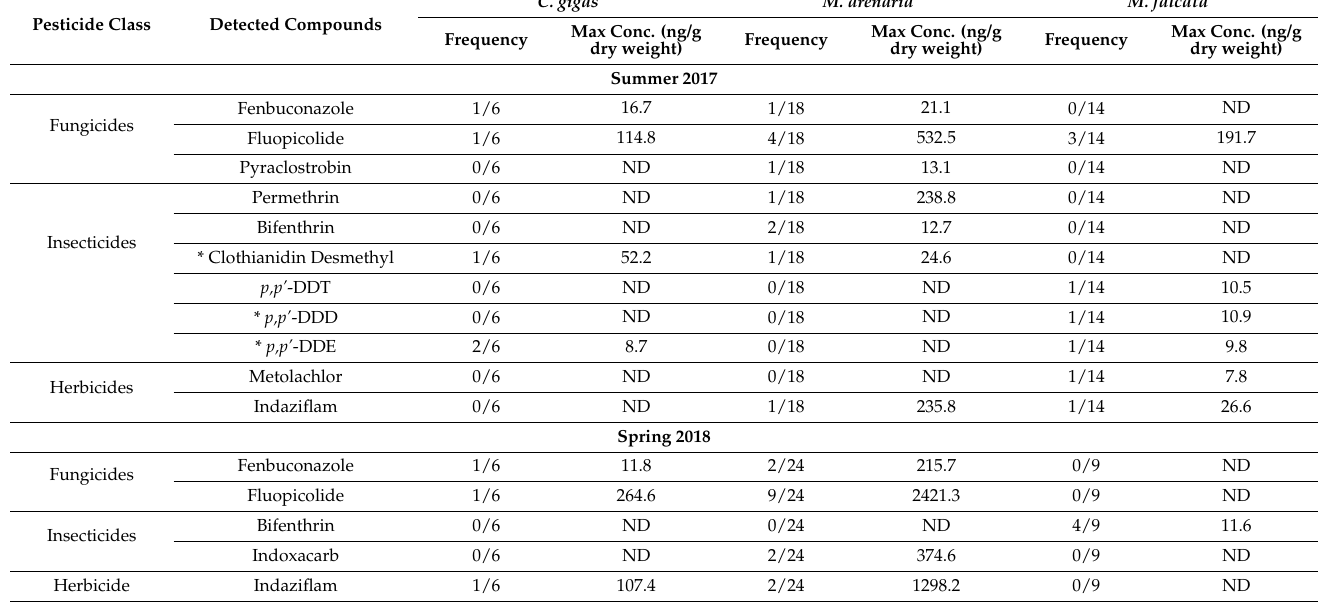
Table 3. Seasonal variability in the class of pesticides, detected compounds, frequency of detection, and maximum concentrations (ng/g dry weight) observed in C. gigas, M. arenaria, and M. falcata tissue during summer 2017 and spring 2018. Approximate method detection limits (MDLs) are 5–10 ng/g, ND indicates non-detect. * indicates a metabolite of a parent compound in this class.